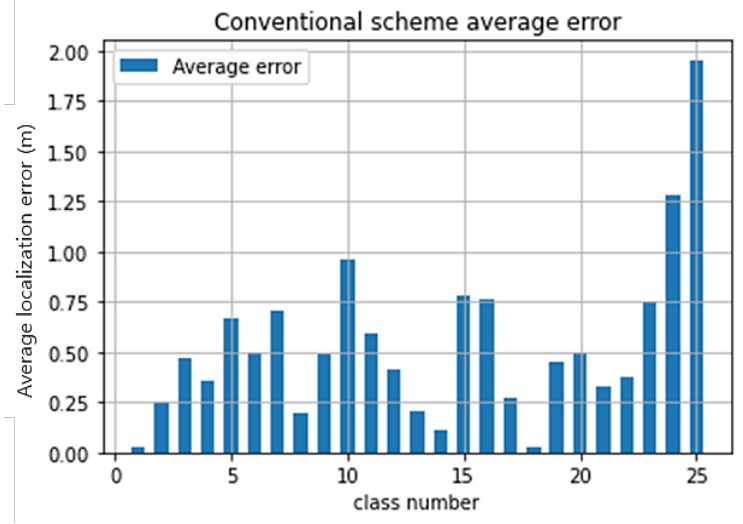
Figure 6. Localization error of conventional scheme.